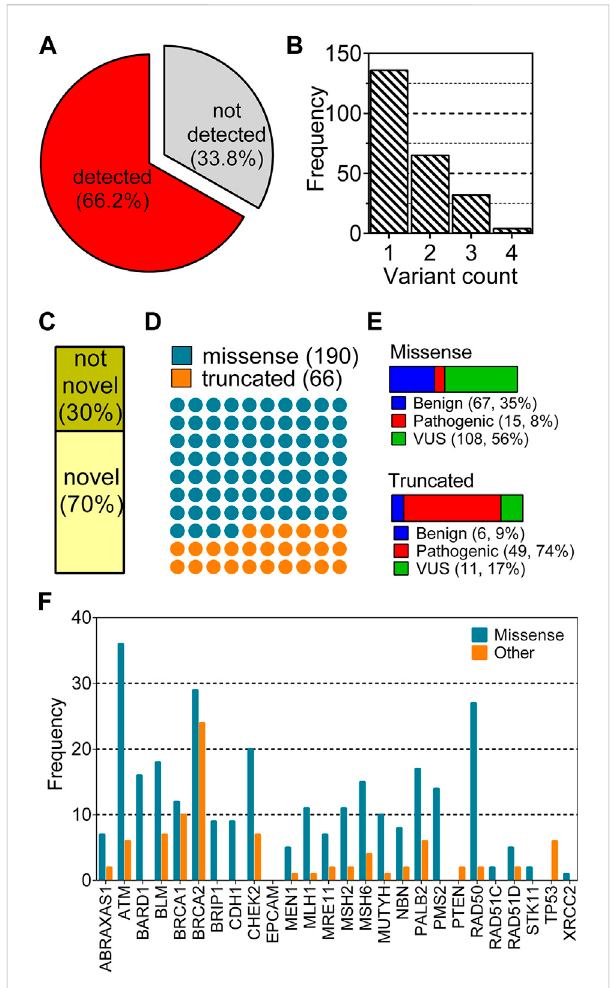
FIGURE 1 Distribution of variant characteristics collected from a cohort of 355 breast cancer patients. (A) shows the distributions of two groups: anytypeof variation detected and not detected in anyof 26 genes; (B) shows distribution of the number of variants for each patient; (C – F) show the distribution of variants according to novelty, type, clinical signi fi cance and gene,